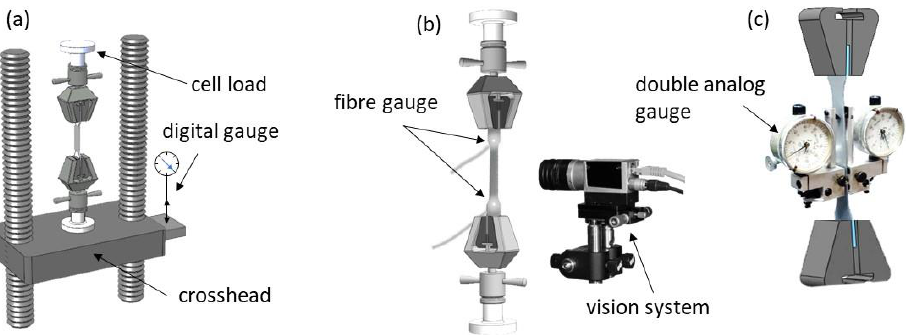
Figure 9. Schematic view of three techniques for acquisition of load and deformation data during uniaxial tensile testing: ( a ) load sensor and digital gauge located on the crosshead, ( b ) vision extensometer, ( c ) analogue extensometer.